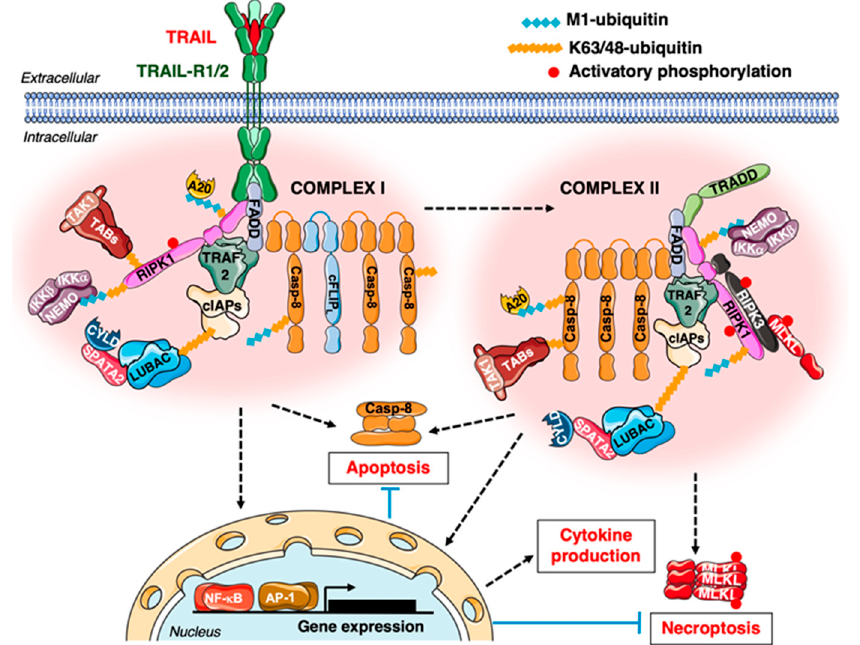
Figure 2. TNF-Related Apoptosis-Inducing Ligand (TRAIL)/TRAIL-Receptor 1 and 2 (TRAIL-R1